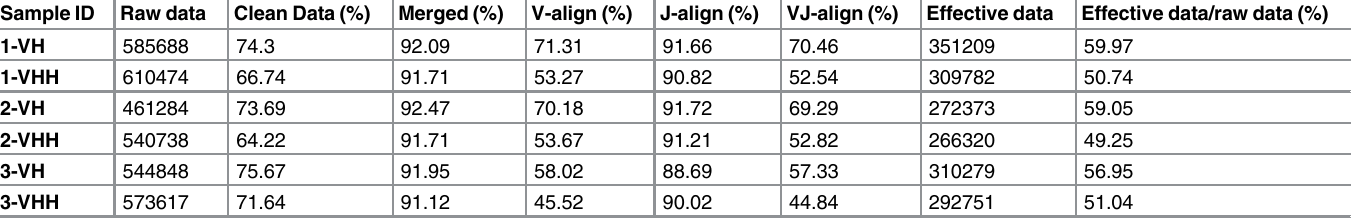
Table 1. Sequencing data overview of three camel